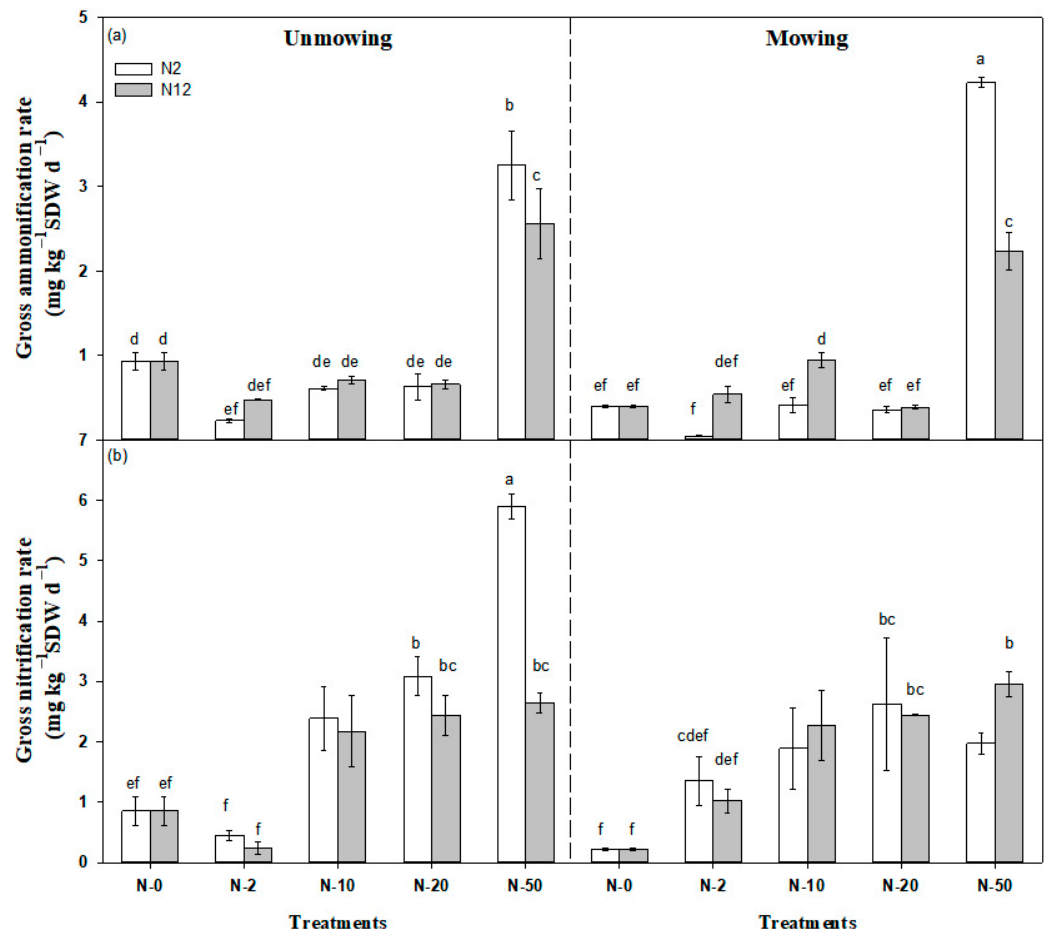
Figure 2. Responses of gross ammonification rate ( a ) and gross nitrification rate ( b ) to N addition level, N addition frequency, and mowing in the temperate steppe. Values are the means of four replicates ± SE (vertical bars). N2 and N12 represent 2 N additions yr − 1 and 12 N additions yr − 1 , respectively. Different lowercase letters represent groups that are significantly different at the p < 0.05 level (Tukey’s HSD test).